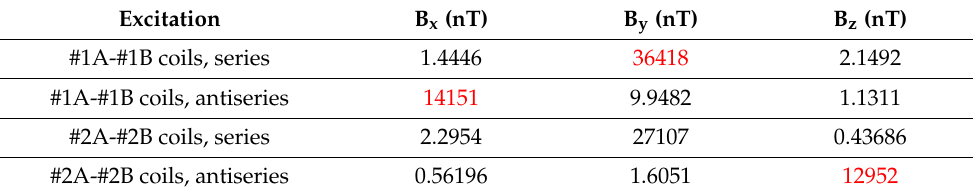
Table 1. Minimum value of the B field components in the cubic region inside the human body for different excitation of the coil array structure. The maximum B field for each component is highlighted in